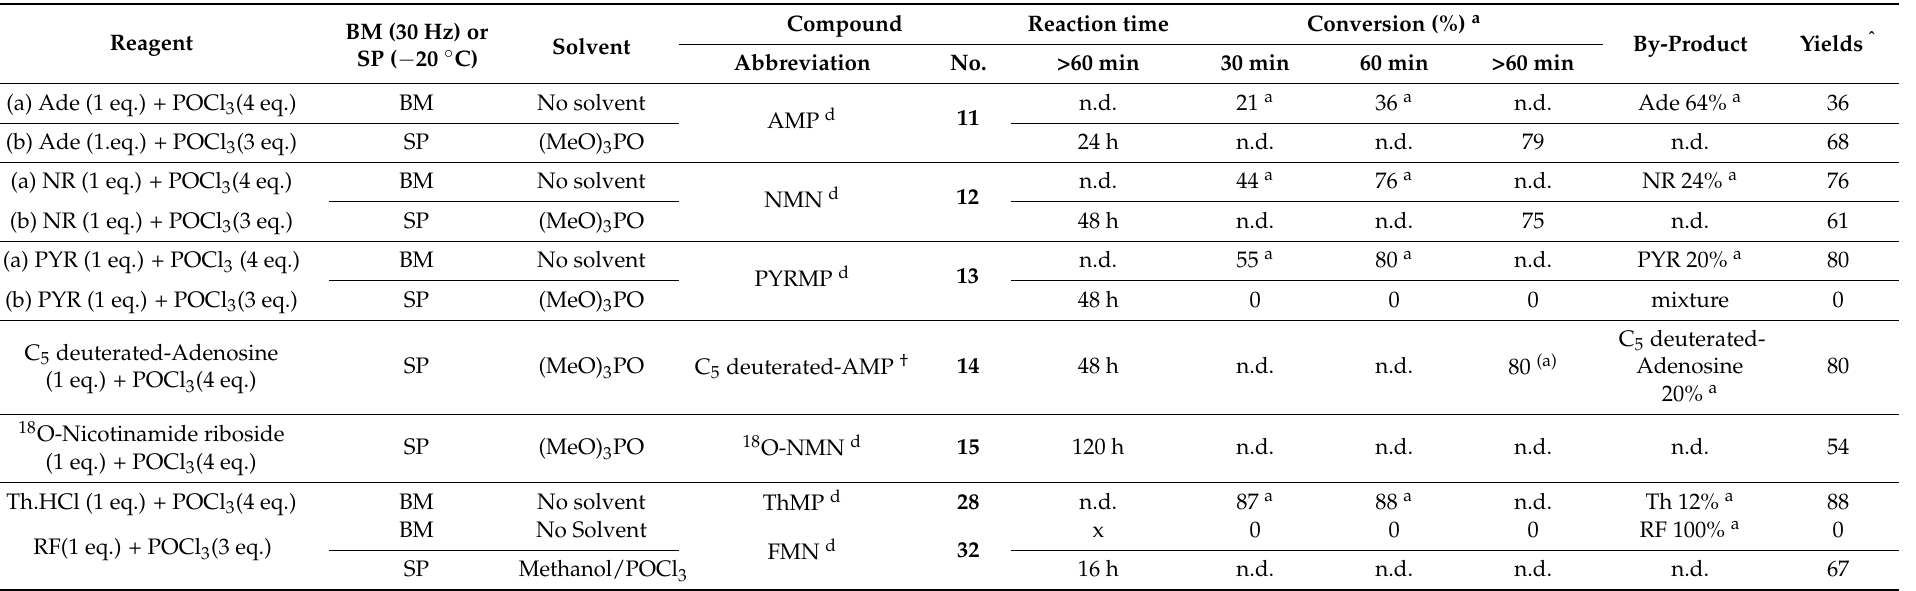
Table 1. Phosphorylation conditions, reaction time, conversions, and isolated yields.